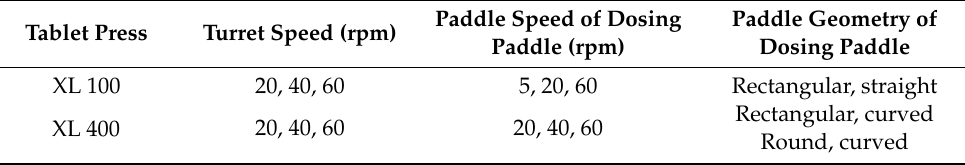
Figure 1. Feed frame of XL 100 ( a ) exhibiting a single chamber equipped with one dosing paddle and feed frame of XL 400 ( b ) consisting of a dosing chamber (left) and metering chamber (right) equipped with a dosing and metering paddle, respectively.